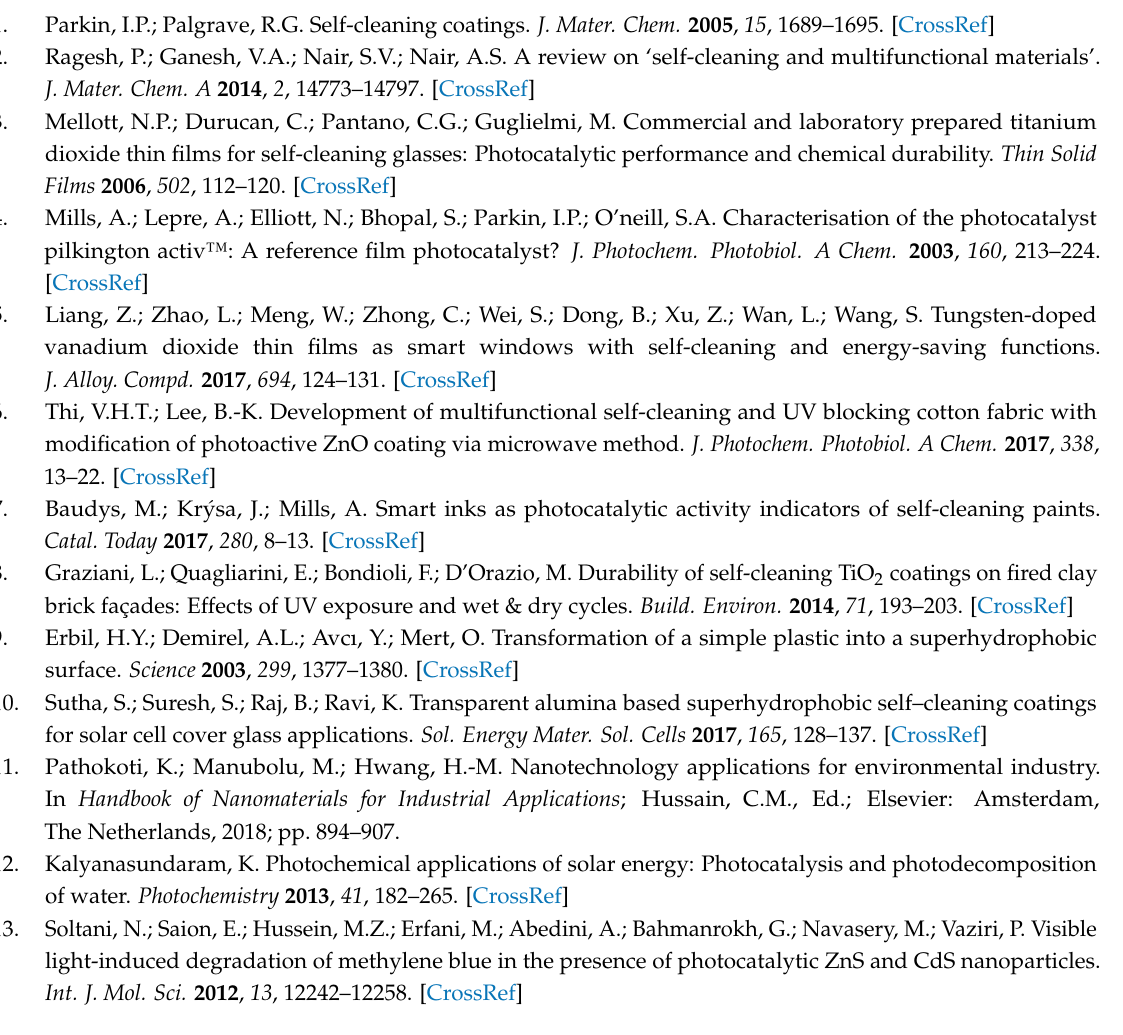
Figure S1: The optical properties of the co-doped ZnO:Ag + Al film. ( a ) Transmittance spectrum; and ( b ) Tauc plot for computation of E g